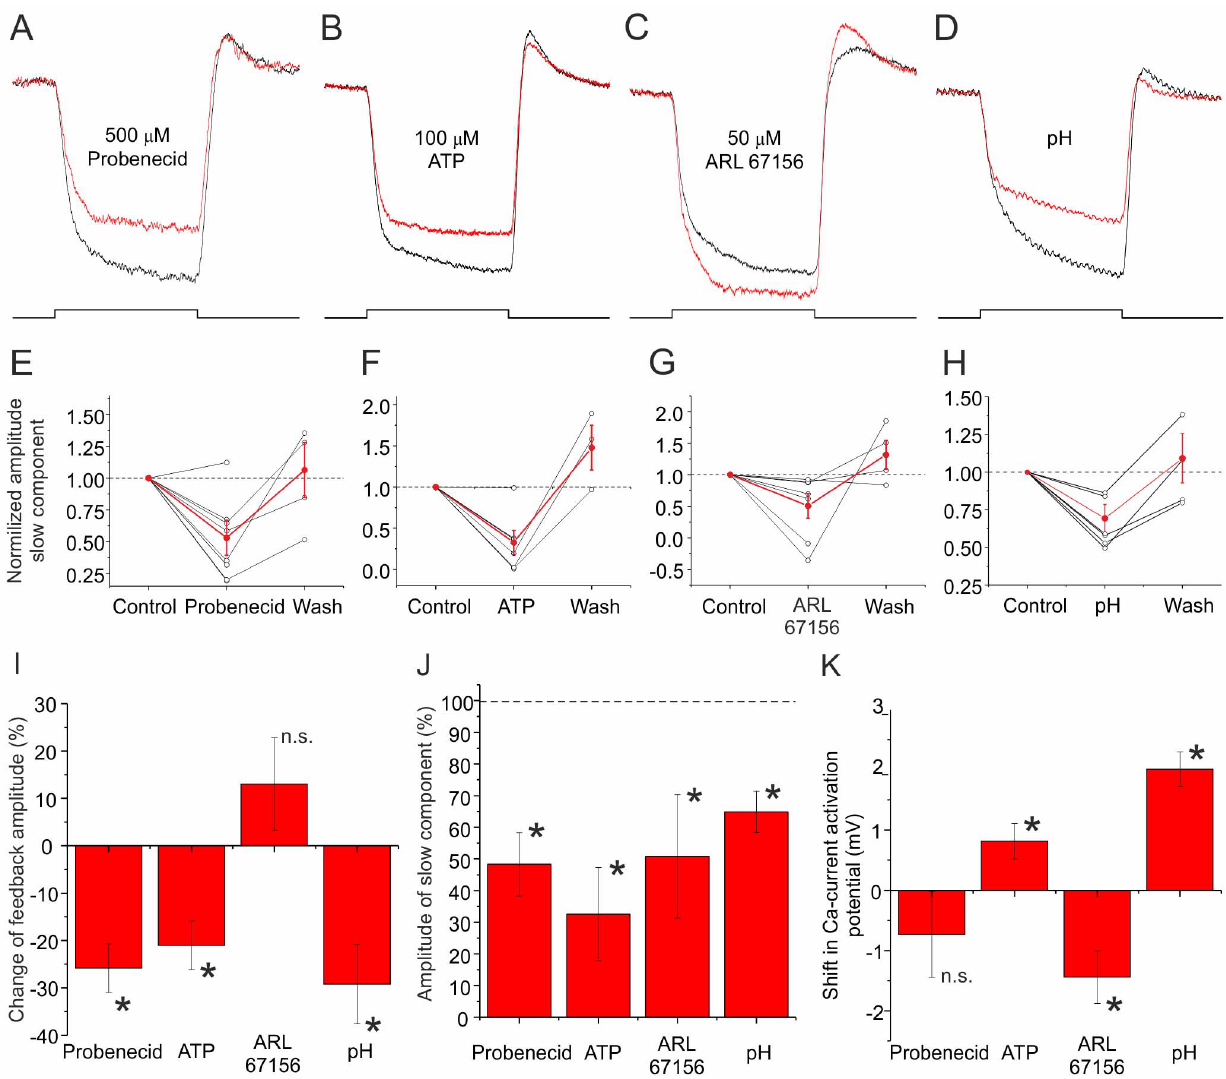
Figure 4. Pharmacological profile of the slow component of feedback. (A) Normalized mean feedback responses of nine cones in control (black) and in 500 m M probenecid (red). The slow component present in control conditions was reduced by probenecid. (B) Normalized mean feedback responses in nine cones in control (black) and in 100 m M ATP (red). ATP blocked the slow component of feedback, indicating the slow component depends on ATP. Note this concentration of ATP does not block Panx1 channels [20]. (C) Normalized mean feedback responses in seven cones in control (black) and in 50 m M ARL67156, a blocker of NTPDase (red). The slow component is reduced by application of ARL67156, indicating that it is mediated by ATP hydrolysis. Feedback response amplitudes were reduced by ATP application (B), but not by ARL67156 application (C), consistent with the notion that a pH buffer generated by ATP hydrolysis inhibits I Ca of the cone by keeping the synaptic cleft slightly acidic. (D) Normalized mean feedback responses in six cones in control (pH 7.6; black) and when the superfusate pH was 7.2 (red). The slow component is strongly reduced when the pH gradient between the synaptic and the extrasynaptic compartments is removed. (E–H) The slow component amplitude for individual cells (black) used in (A–D) during control, drug application, and wash. The red line indicates the mean 6 sem. In each case, the changes of the slow component amplitude were reversible. The figures also suggest that the slow feedback component may have increased slightly over time. (I) The mean 6 sem change in the total feedback amplitude relative to control levels for the results shown in (A–D). Probenecid ( p =0.003), ATP ( p =0.0093), and pH ( p =0.0175) all reduced the feedback amplitude significantly. Only ARL67156 did not change the amplitude significantly ( p =0.2295). (J) The mean 6 sem amplitude reduction for the slow component of feedback relative to control values for the results shown in (A–D). In each case, the amplitude reduction of the slow component was significant (probenecid, p =0.0009; ATP, p =0.036; ARL67156, p =0.045; pH, p =0.010). (K) The change in half activation potentials of I Ca when 500 m M probenecid, 100 m M ATP, or 50 m M ARL67156 were present in the bath solution or when the extracellular pH was shifted to 7.2. Probenecid did not induce a significant shift of the activation potential of I Ca ( n =9; p =0.3375). ATP shifted the half activation potential to more positive potentials ( n =8; p =0.0277), whereas ARL67156 shifted it to more negative potentials ( n =8; p =0.0131). Lowering the extracellular pH led to a significant shift of I Ca to positive potentials ( n =5; p =0.0022).